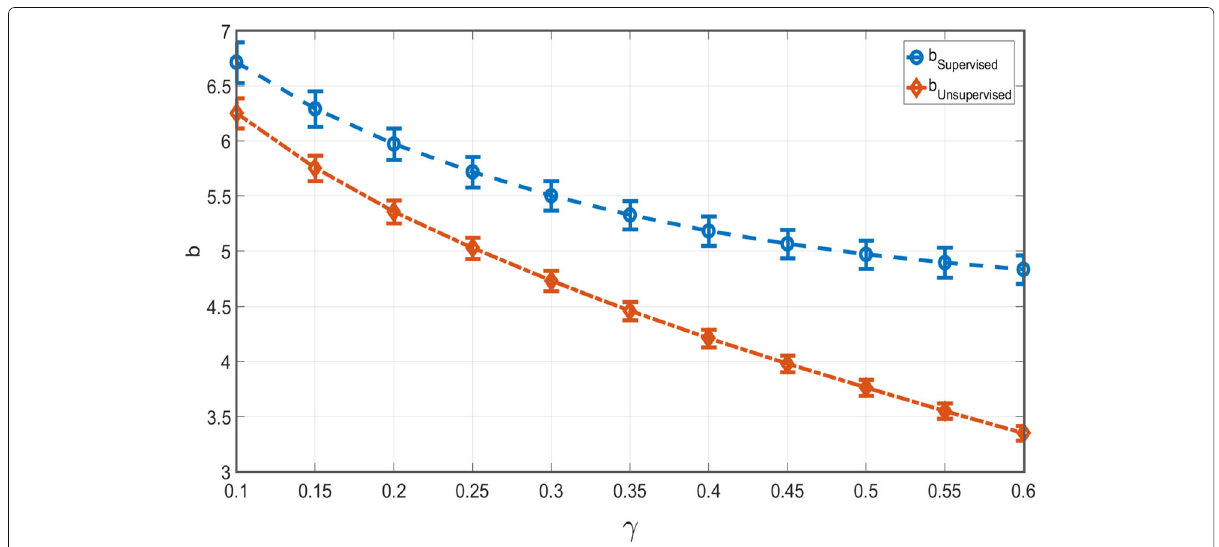
Fig. 6 Estimation of the b parameter. Comparison of the mean and standard deviation evolution for the parameter b as a function of the dispersion γ of a S α S noise with α = 1.4 for the supervised and unsupervised